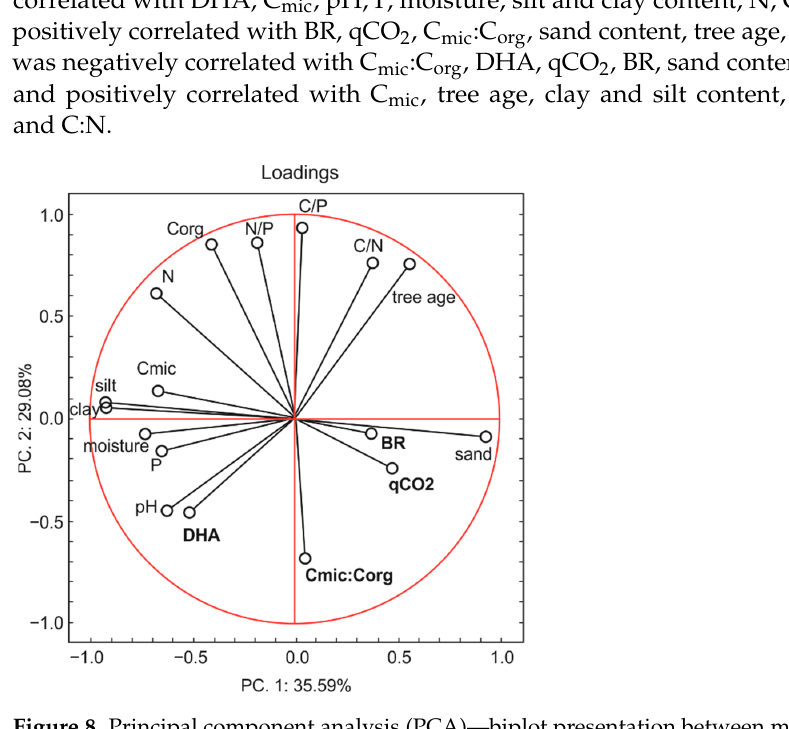
Figure 8. Principal component analysis (PCA)—biplot presentation between microbial and physicochemical parameters of six forest soils.